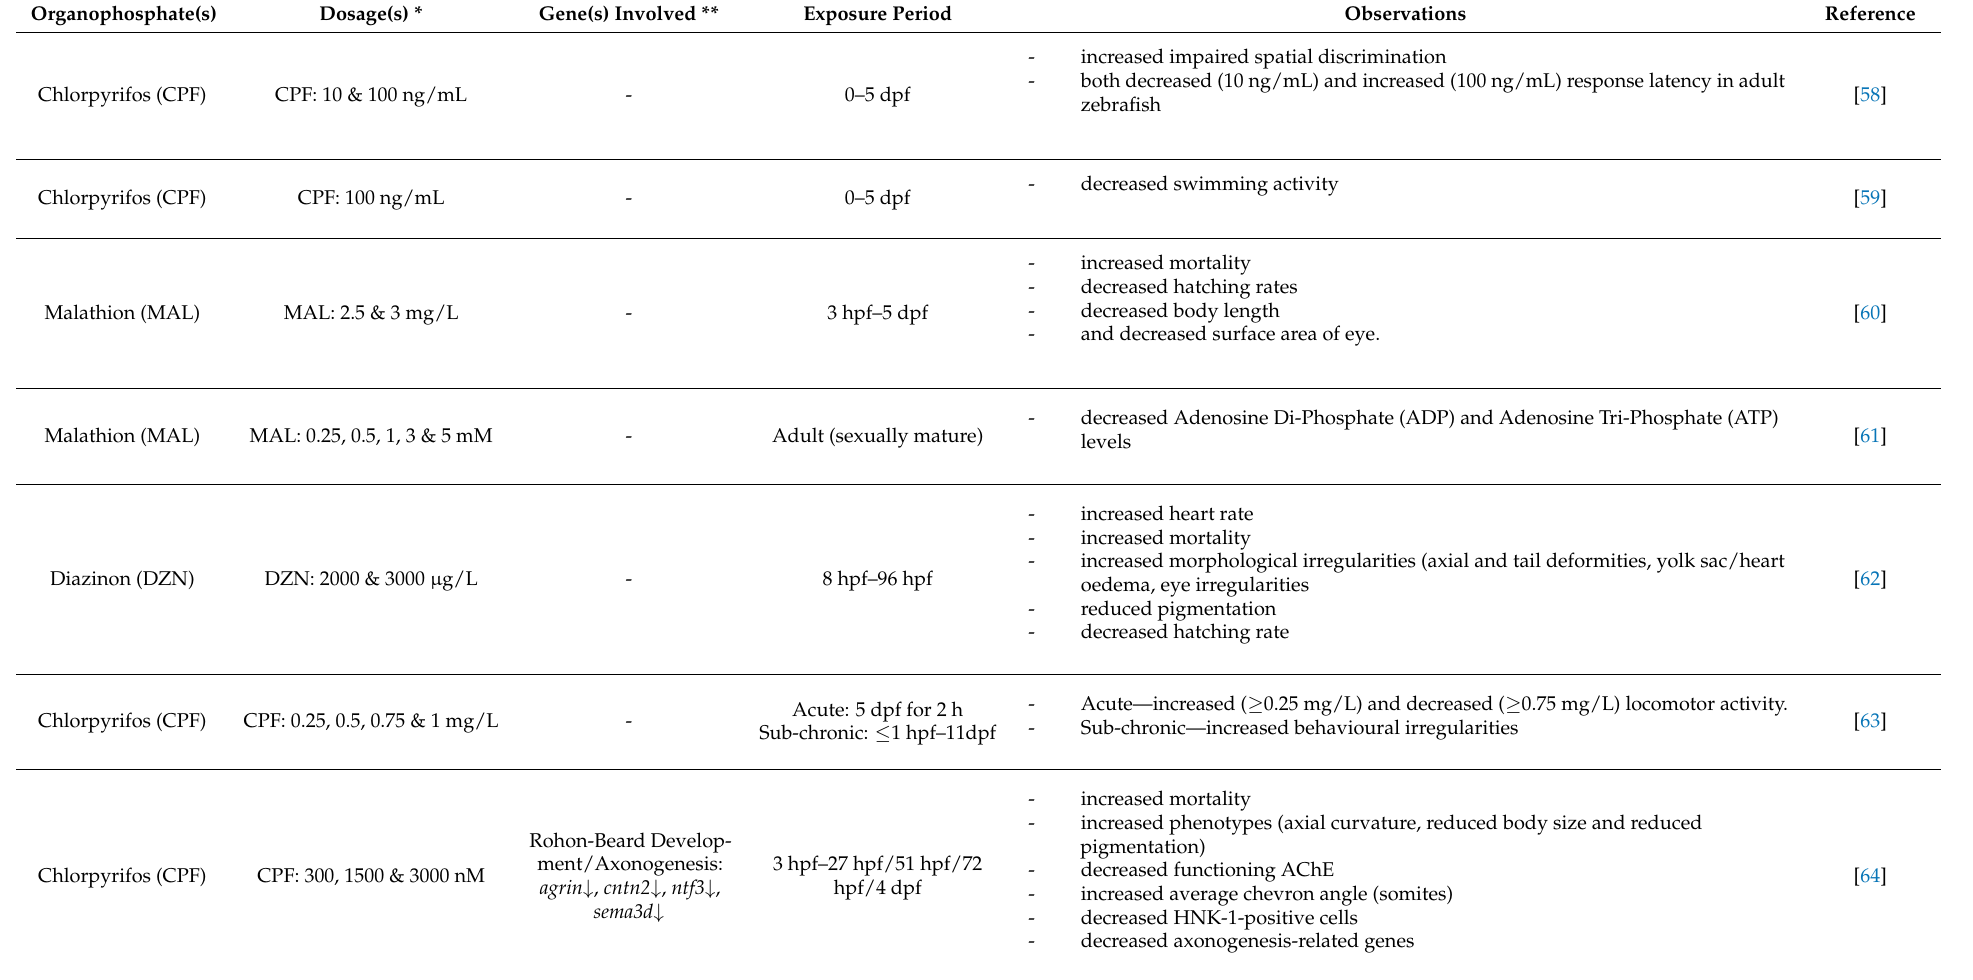
Table 2. Studies utilising zebrafish ( Danio rerio ) to determine developmental and neurotoxic effects of organophosphate insecticides. dpf; days post-fertilisation. hpf; hours